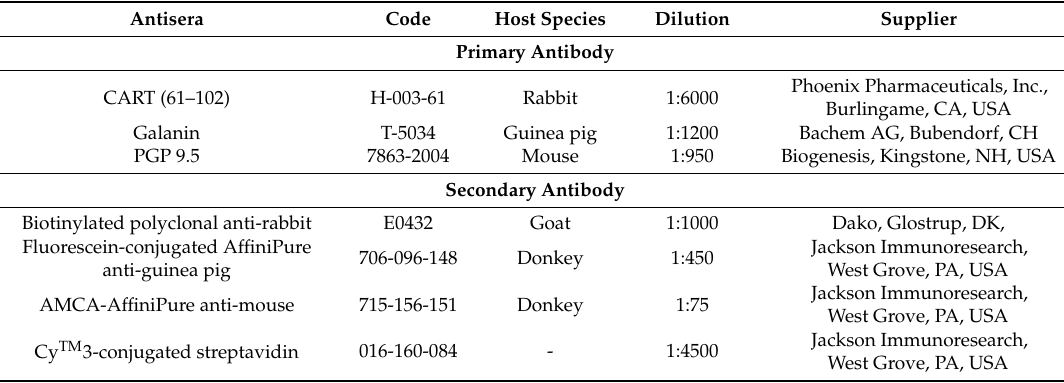
Table 2. Immunoreagents used in the present